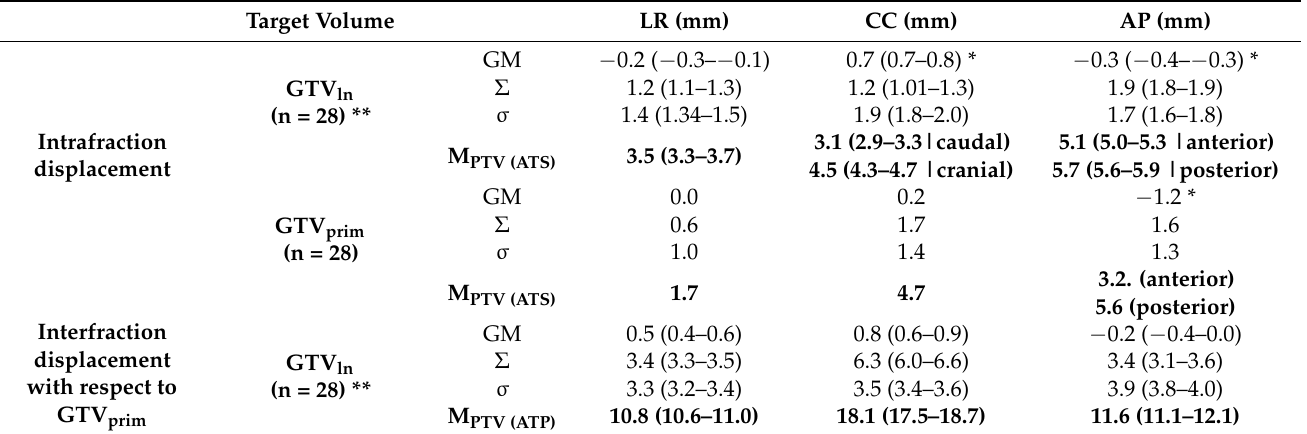
Table 2. Summary information for GTV ln (n = 30) and GTV prim (n = 30) inter- and intrafraction motion calculated using van Herk PTV margin recipe. Translations are shown in left–right (LR), anterior– posterior (AP) and cranial–caudal (CC) directions. Positive values indicate motion in right, cranial, and posterior directions. GM = mean of patient motion, Σ = systematic error, σ = random